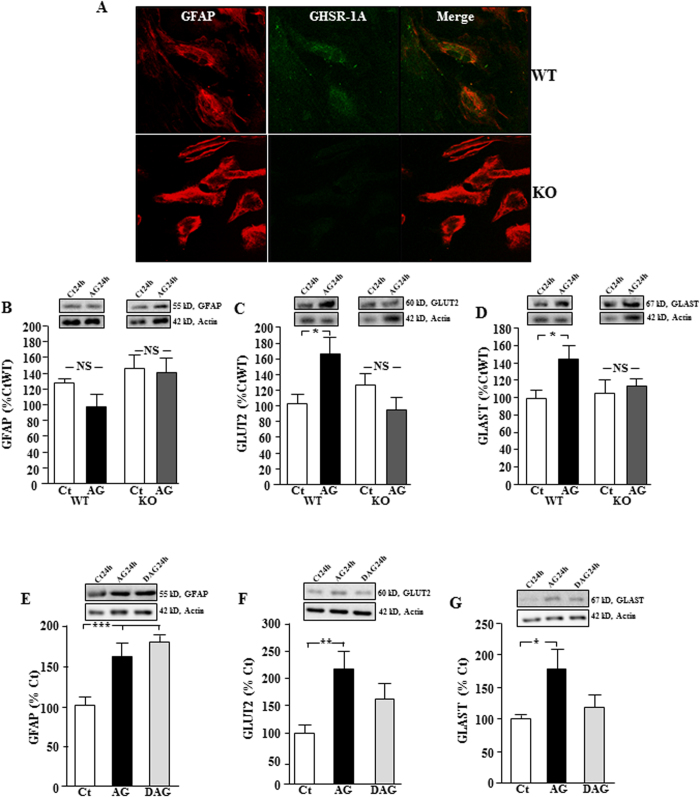
Role of GHSR-1A in the response of astrocytes to ghrelin.Double immunofluorescence for GHSR-1A (green) and glial fibrillary acidic protein (GFAP, red) in cultures of hypothalamic astrocytes of wild-type (WT) and GHSR-1A (knock-out, KO) male mice (A). Levels of (B) GFAP, (C) glucose transporter (GLUT)2 and (D) glutamate-aspartate transporter (GLAST) in primary hypothalamic astrocyte-enriched cultures of WT and GHSR-1A KO male mice treated with acyl-ghrelin (AG) or vehicle (Ct). In order to further analyze the involvement of GHSR-1A in the response of astrocytes to acyl-ghrelin (AG), primary hypothalamic astrocyte-enriched cultures were treated with AG, desacyl-ghrelin (DAG) or vehicle (Ct) and the relative levels of (E) GFAP, (F) GLUT2 and (G) GLAST were measured. *p < 0.05, **p < 0.001, ***p < 0.0001, NS = not significant. Representative Western blots are from the same gel although samples were not always contiguous within the gel.